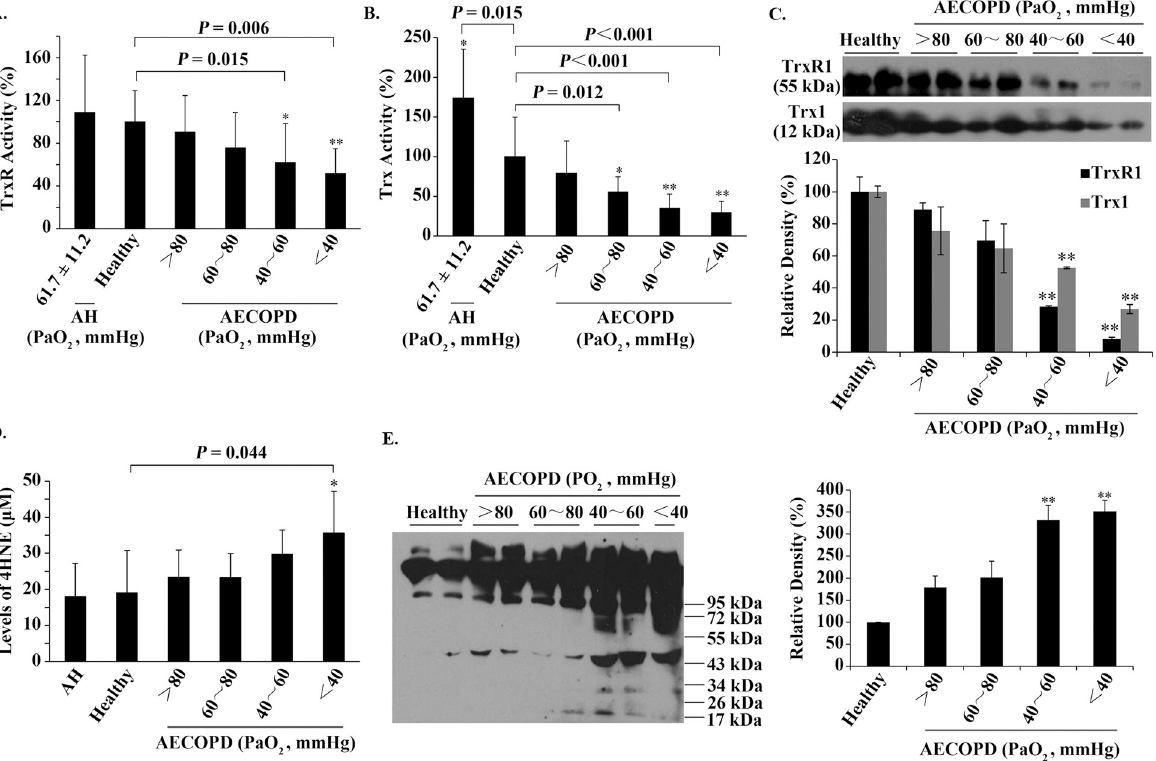
Fig 1. The relationships among serum TrxR/Trx, serum 4HNE and PaO 2 . ( A ) The relationship between the activity of serum TrxR and PaO 2 . ( B ) The relationship between the activity of serum Trx and PaO 2 . ( C ) Representative Western blots (upper panel) and relative density values (bottom panel) for the bands in the upper panel. ( D ) The relationship between the level of serum 4HNE and PaO 2 . ( E ) Representative Western blots (left panel) and relative density values (right panel) for the bands in the left panel. In the bar graphs, the values are expressed as mean ± S.D. (n � 3). � , P < 0.05; �� , P < 0.01 versus healthy